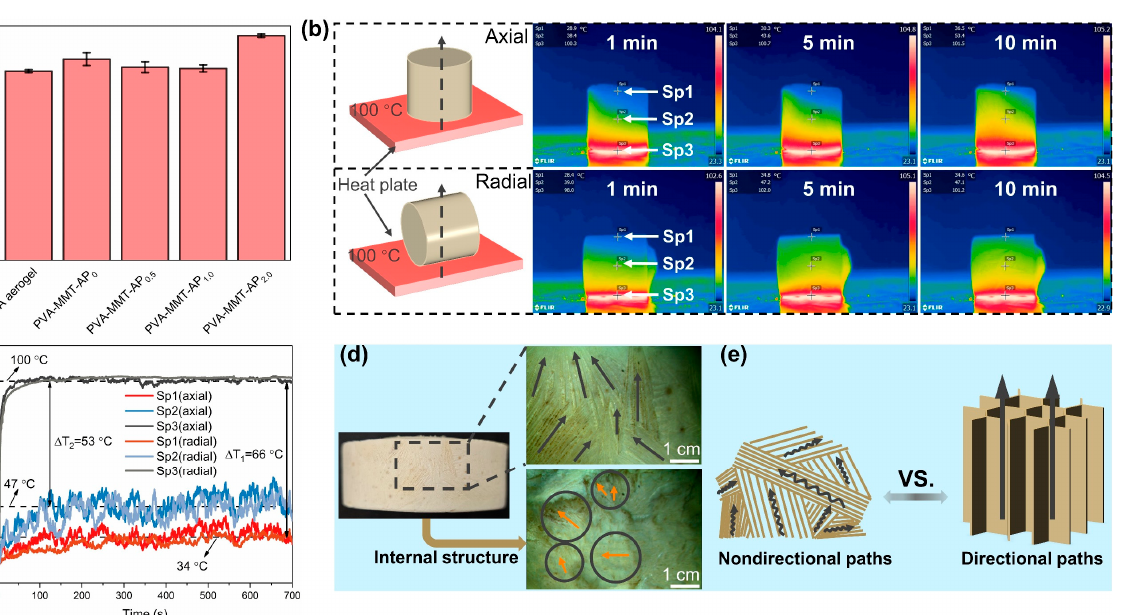
Figure 4. ( a ) Thermal conductivity of the PVA aerogel and PVA-MMT-AP x aerogel composites. ( b ) Infrared thermographic images of the PVA-MMT-AP 1.0 with a size of Φ 2 cm × 2 cm on the hot surface of 100 °C. ( c ) The time-dependent temperature profile at the points of Sp1, Sp2 and Sp3 in the axial and radial directions (Sp1, on the upper end; Sp2, on the middle; and Sp3, on the bottom). ( d ) The texture of the PVA-MMT-AP 1.0 . ( e ) The schematic of the heat transfer through nondirectional or directional paths.